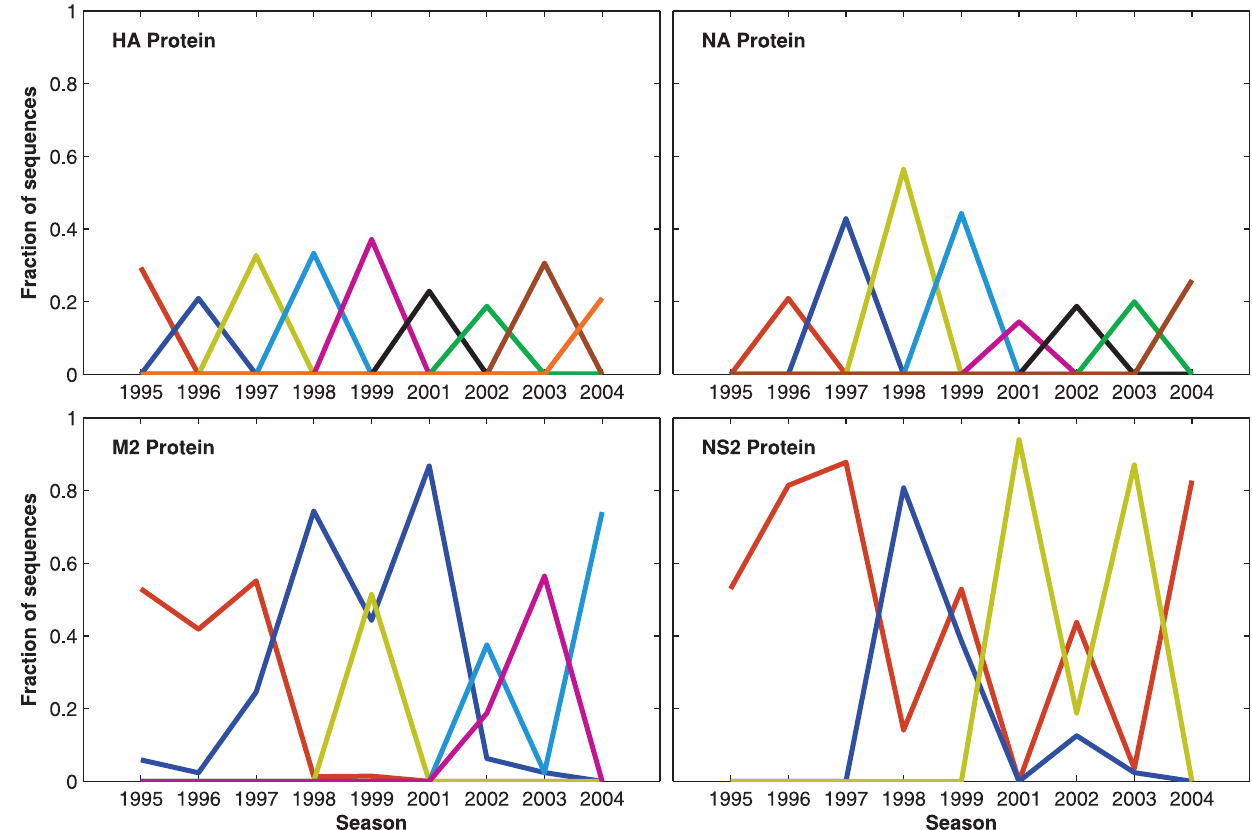
Figure 2. Dominant sequences over time. Different influenza proteins had different temporal patterns of dominant sequences. HA and NA had a different dominant sequence each season, each of which made up a relatively small proportion of samples from that season. Dominant sequences were a larger proportion of all sequences of the internal proteins. The two proteins with the highest proportion of dominant sequences and the longest duration of dominance were NS2 and M2. The fraction of sequences for each dominant sequence changed by season, but nearly all dominant sequences persisted for multiple seasons in these proteins. The x-axis represents influenza season, and the y-axis represents the fraction of all sequences in that season. Each line color represents a distinct dominant sequence, and each occurrence of the dominant sequence had an identical amino acid sequence. E.g., for the HA protein, the dominant sequence represented by the dark blue line was 20% of all HA sequences in the 1996 season, but was absent in 1995 and in 1997 and